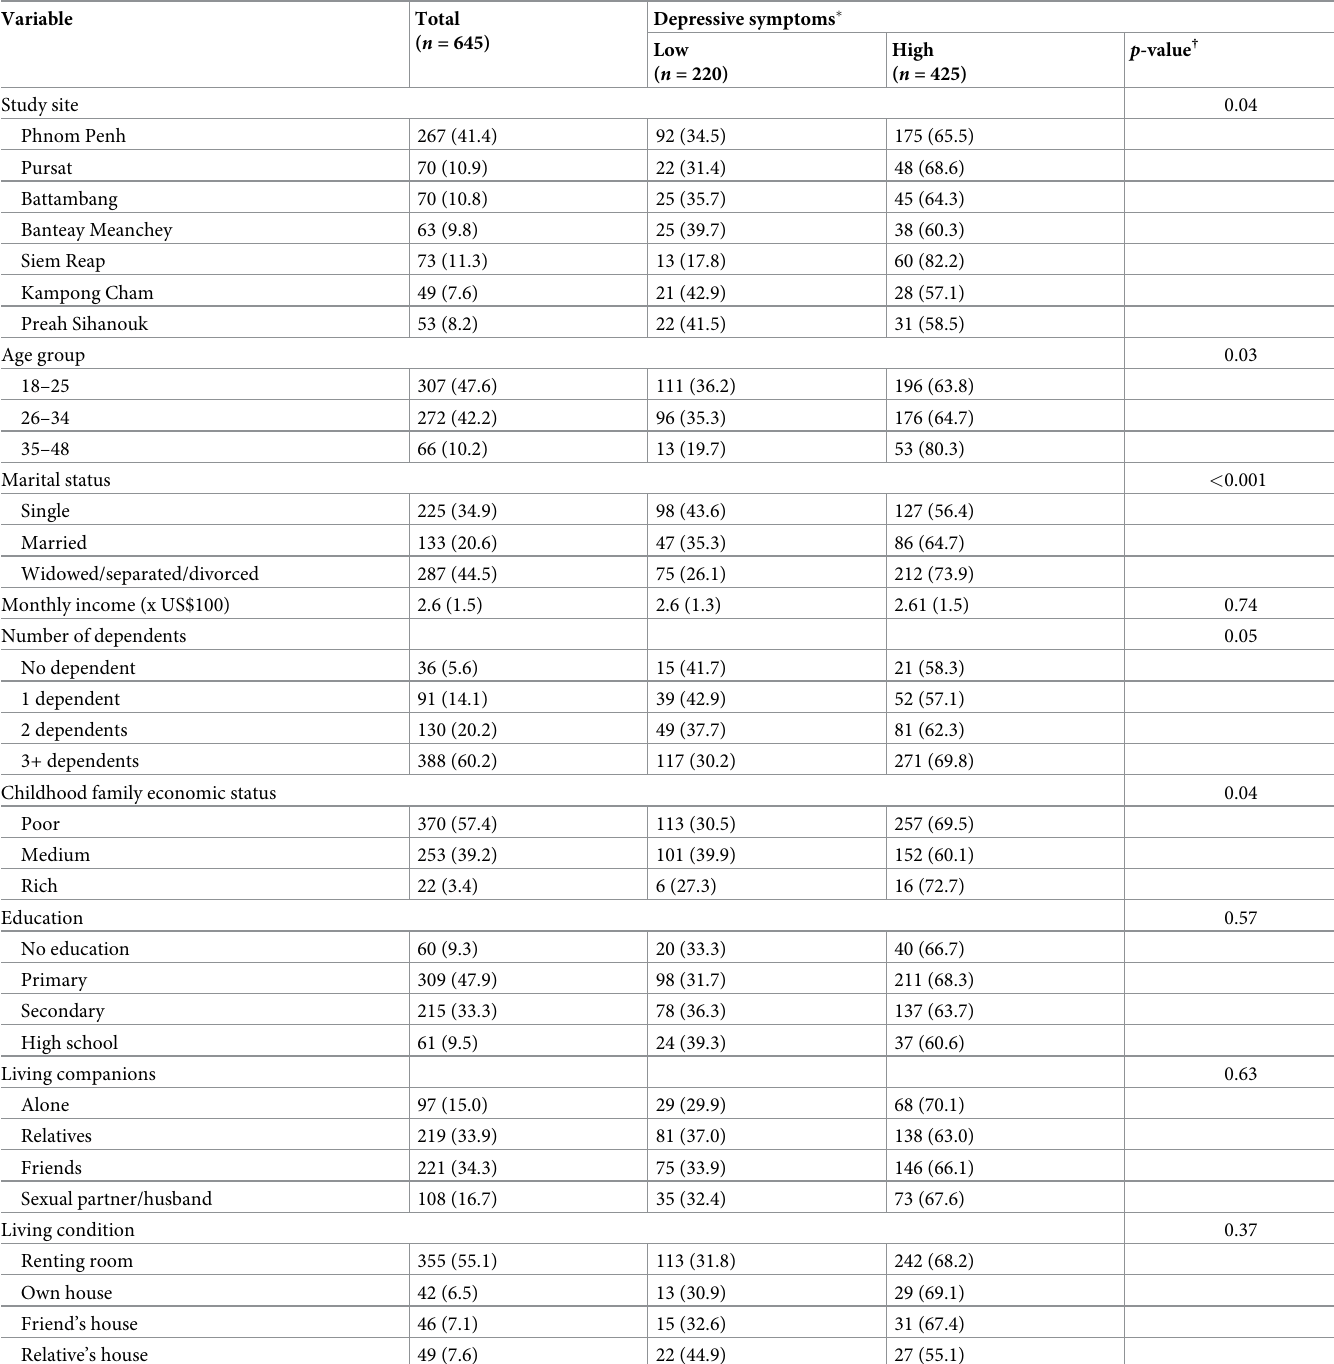
Table 1. Comparison of socio-demographic characteristics of FEWs with low and high levels of depressive symptoms ( n =